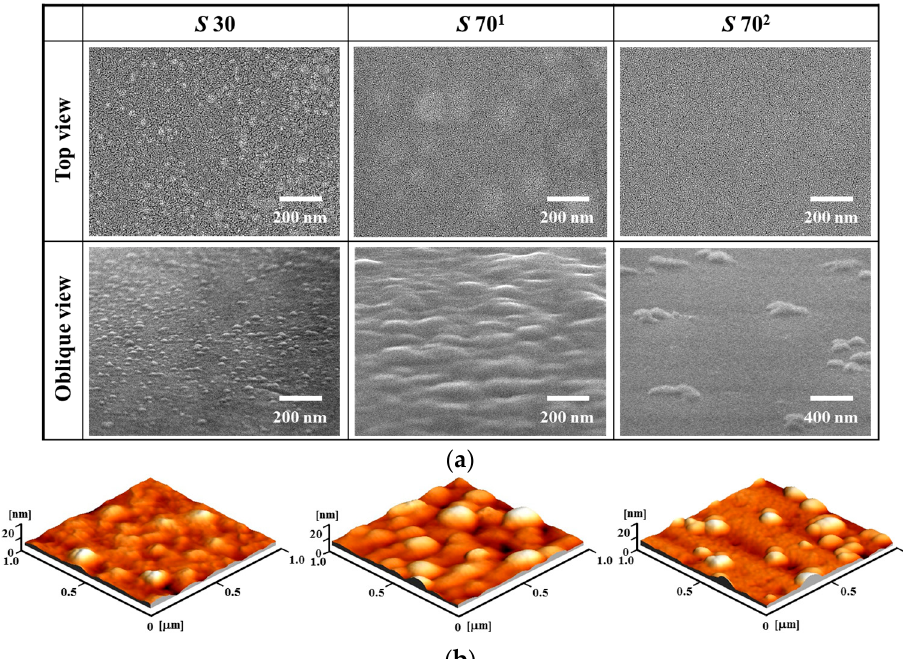
Figure 4. ( a ) SEM images with top-view and oblique-view and ( b ) AFM images for the plasma-treated surface of S 30, S 70 1 , and S 70 2 substrates.